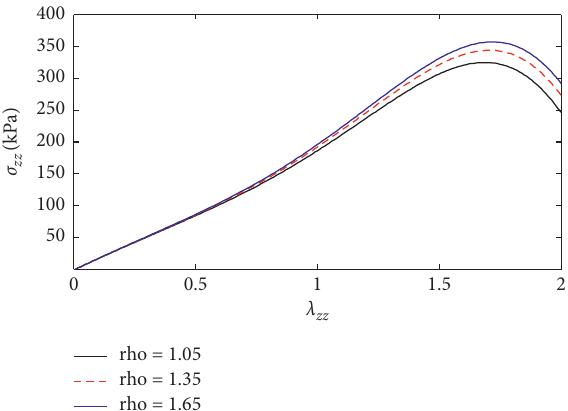
Figure 14: Influence of blood density on axial